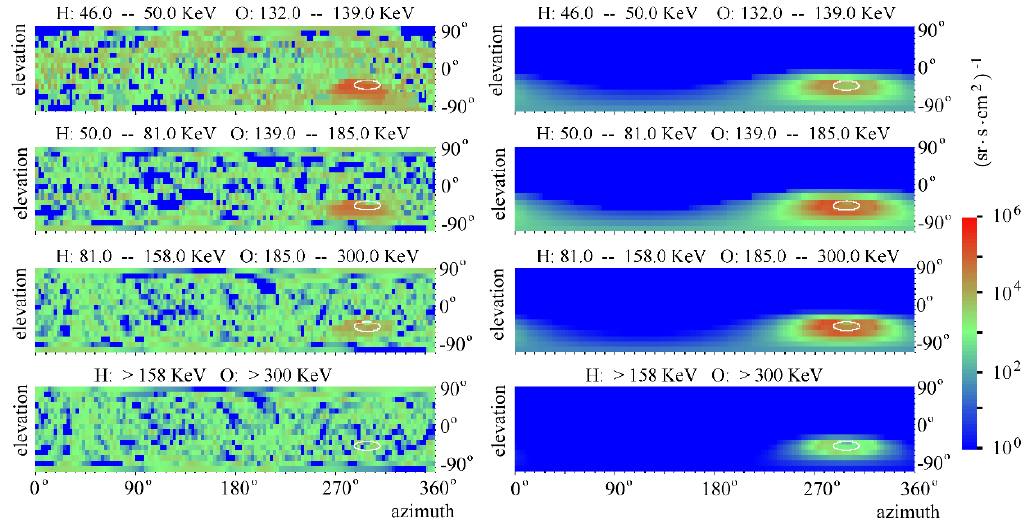
Figure 6. Comparison between the observed ( left ) and the simulated ( right ) images, for 8 November 2004 03:53:37 UT. [55].